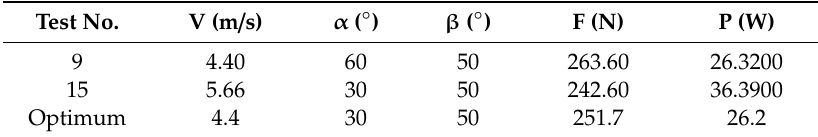
Table 6. The optimum test compared to two normal